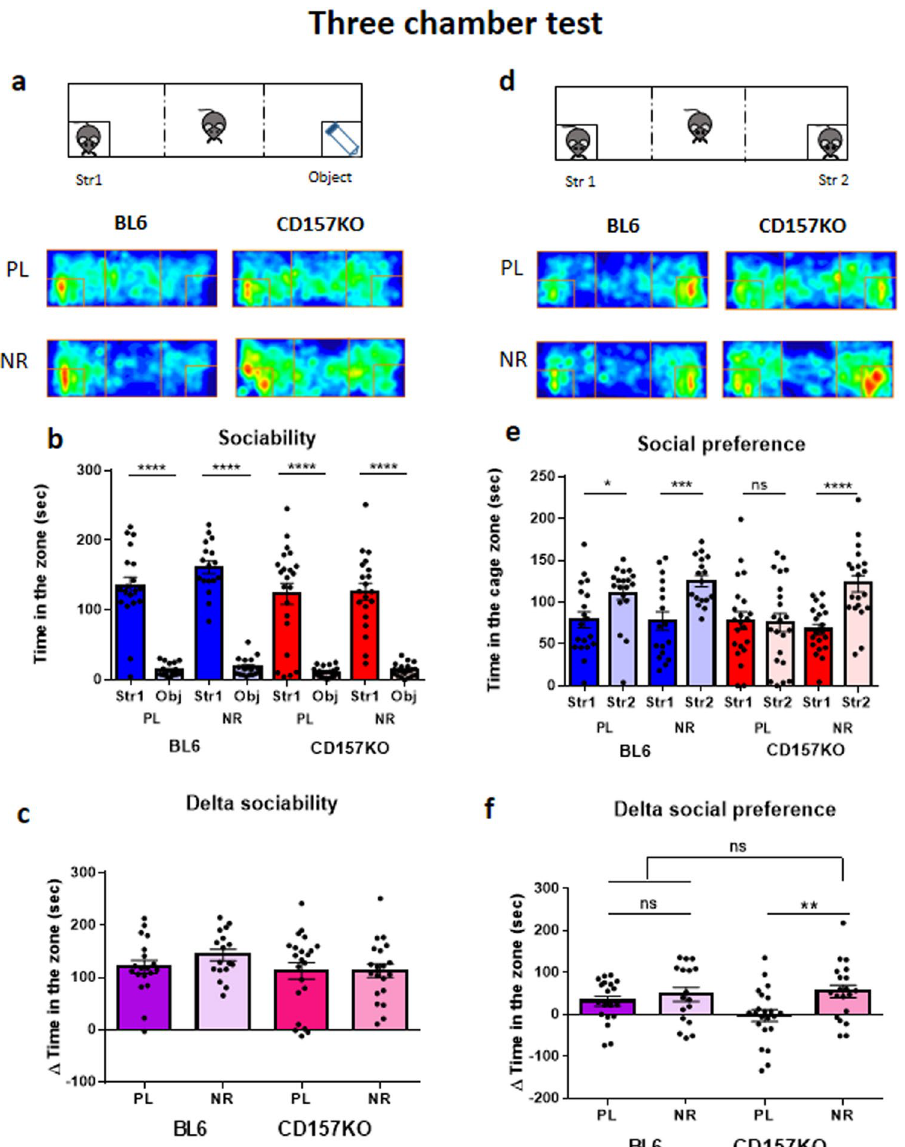
Figure 2. Social interaction of adult male wild-type (C57BL/6 N and BL6) and CD157KO mice in the three- chamber test. The sociability stage ( a – c ) and social preference stages ( d – f ). Experimental schemes in the sociability task when a stimulus male mouse (Str 1) was placed in the left chamber ( a ) or in the social novelty task when a new target male mouse (Str 2) was placed in the right chamber ( d ). Group occupancy plots of test mice initially place in the center in the sociability stage ( a ) or social preference ( d ) by the three-chamber box test after oral administration of saline (PL) or nicotinamide riboside (NR, 3 mg/mouse) treatment for 12 days. ( b ) Time spent in the wire mesh cage with the social target mouse (a conspecific male mouse, Str 1) or a non- social object (a test tube, Obj). Unpaired t -test shows significace between Str 1 and Obj at **** P < 0.0001. ( c ) The delta sociability represents time difference between social and non-social targets. ( e ) Time sp e nt by test wild-type (BL6) or CD157KO mice in the cage with a familiar (Str 1) or new unfamiliar (Str 2) target mouse is plotted. Note that social preference was observed in wild-type mice under 2 conditions (PL and NR). While no social preference was observed in CD157KO mice treated with saline (PL), preference was obvious in KO mice treated with NR. Unpaired t -test shows significance between Str 1 and Str 2 at * P < 0.05, ** P < 0.01, *** P < 0.001, and **** P < 0.0001. ( f ) The time by NR-treated CD157 KO mice spent with an unfamiliar mice was significantly higher than that with a familiar mouse. Two-way ANOVA, effect of treatment, F 1,74 = 6.412, P < 0.0135. Bonferroni’s post hoc analysis shows P < 0.01 between PL and